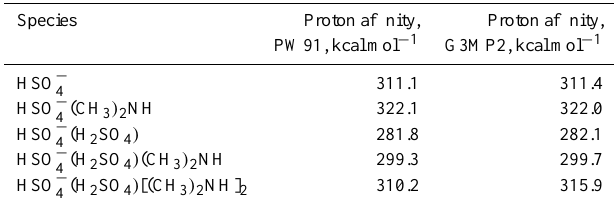
Table 5. Proton affinities (at the PW91/6-311++G(3df, 3pd) and G3MP2 levels) for clusters of the hydrogensulfate ion with sulfuric acid and/or